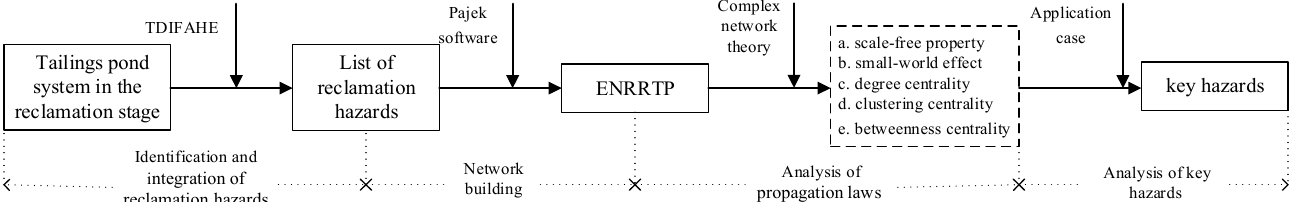
Figure 1. A flow chart of research methods and results.